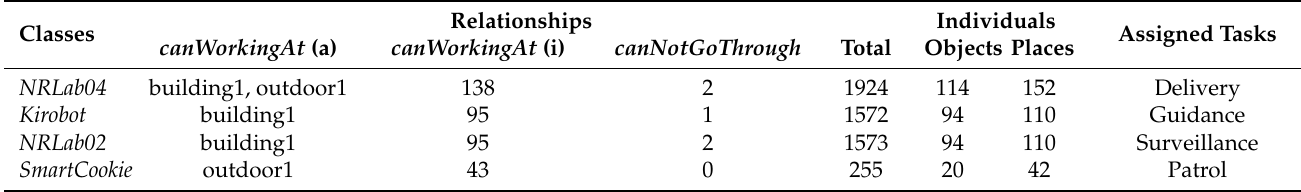
Figure 7. Robot ’s individuals used for the experiment. ( a ) is TricycleRobot , ( b , c ) are DifferentialRobot , and ( d ) is OmnidirectionalRobot . Table 5. On-demand semantic database for each subclass of Robot